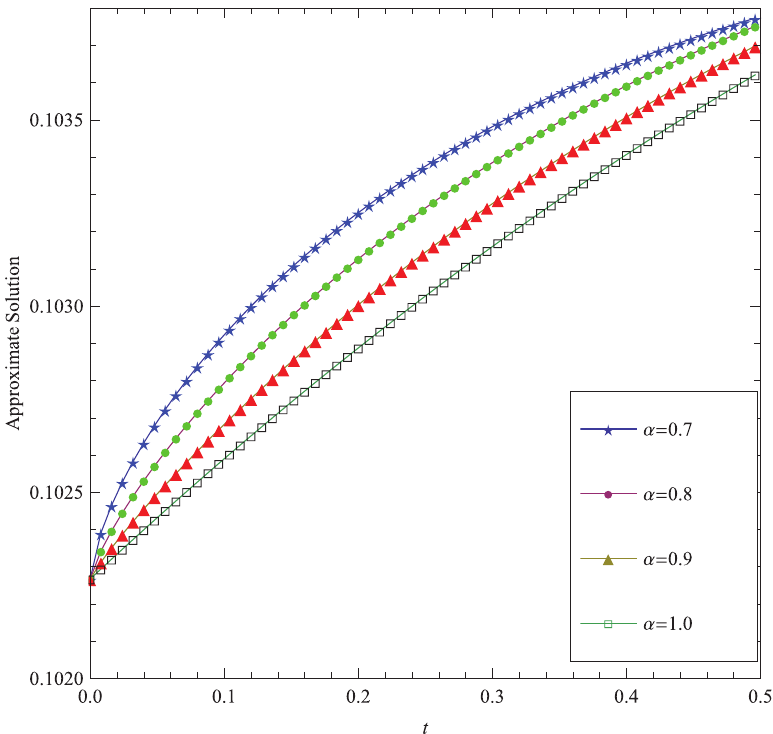
Figure 6. Plot of u n ,7 ( x , t ) versus time t for different values of α at a = b = 0.1 and ℎ = −